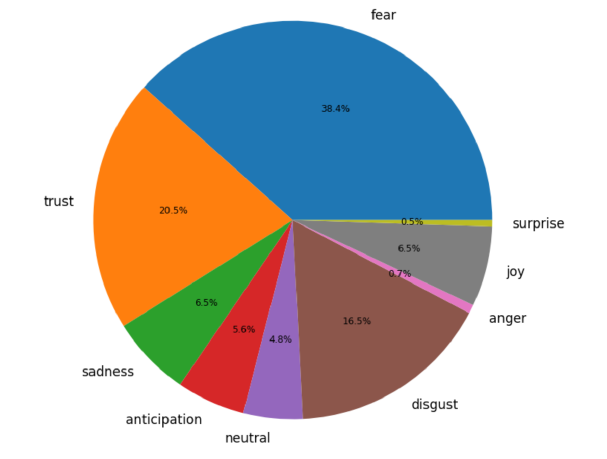
Figure 15. Emotion distribution.